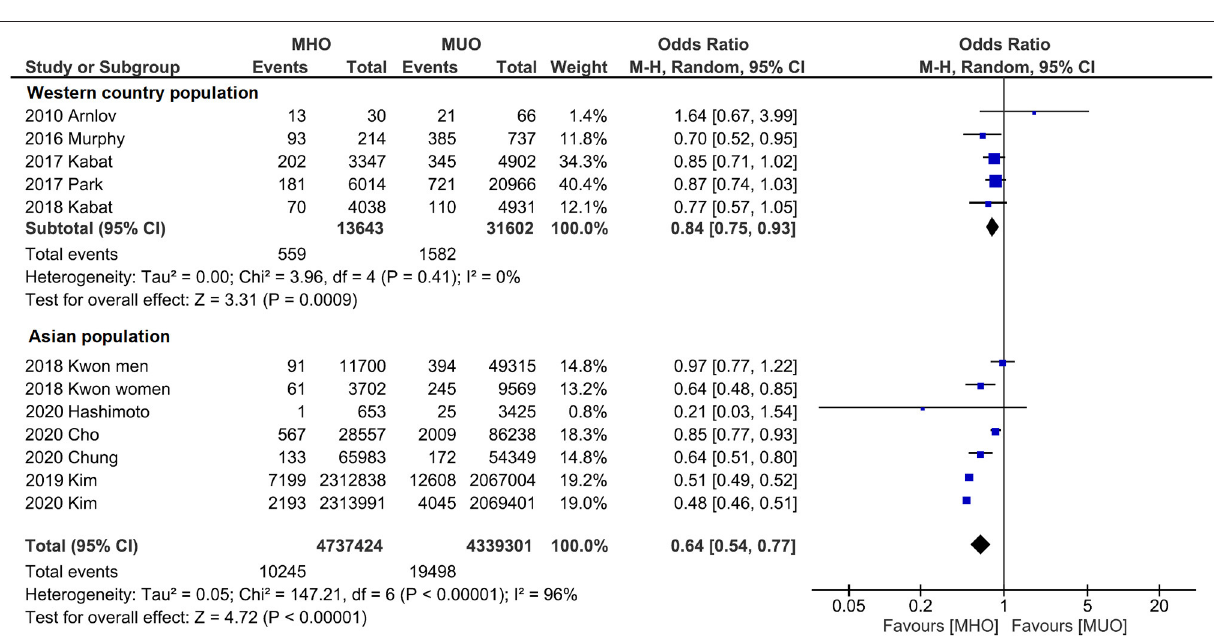
different definitions of metabolic health have been used